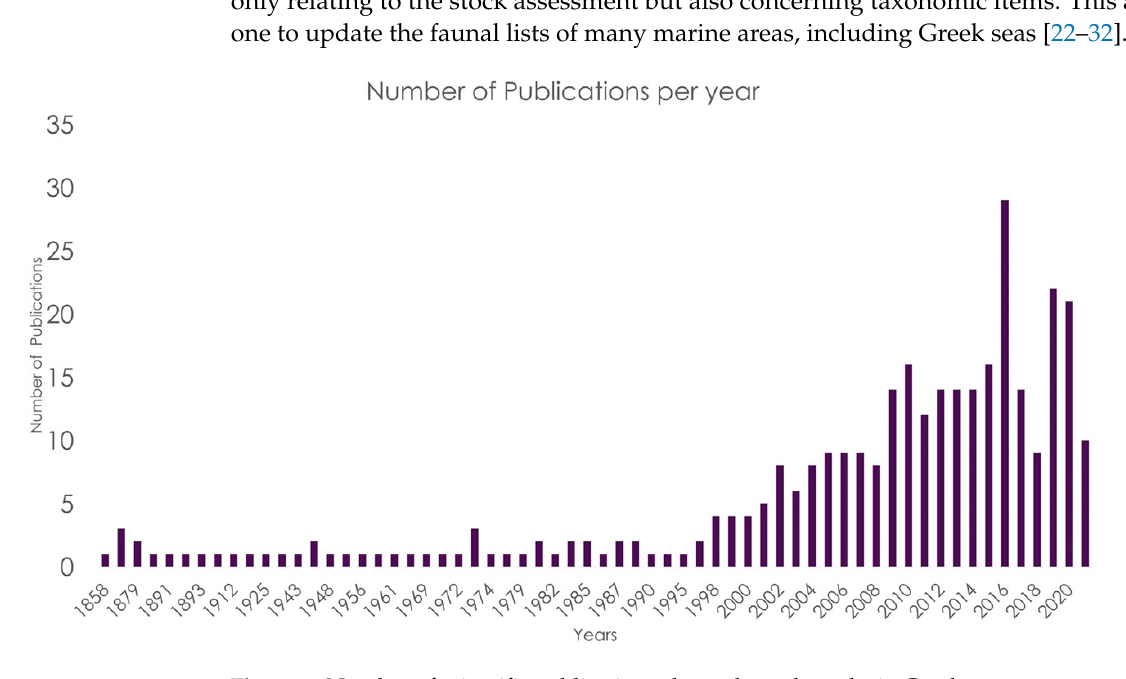
Figure 4. Number of scientific publications about elasmobranchs in Greek waters per year.